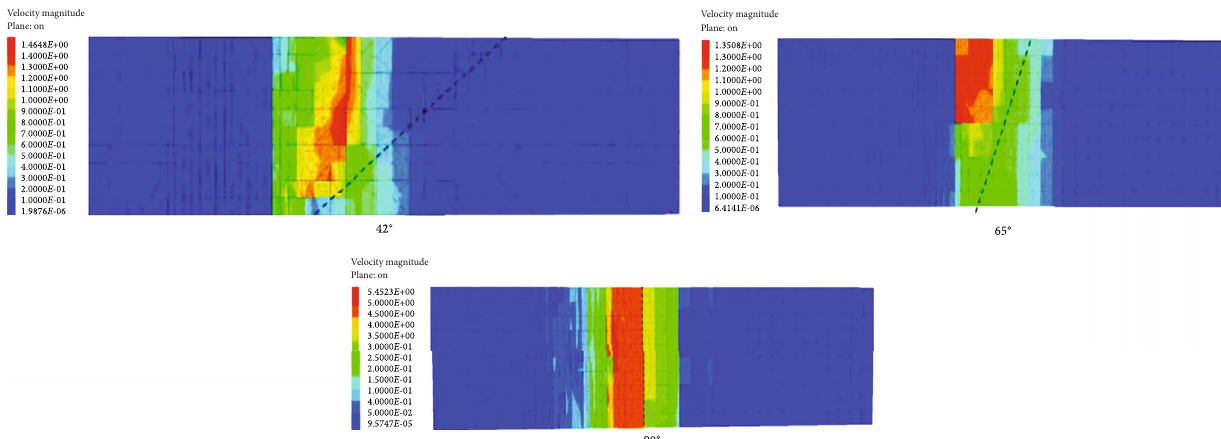
Figure 8: Rate cloud of coal and rock mass when the working face is 5 m away from the